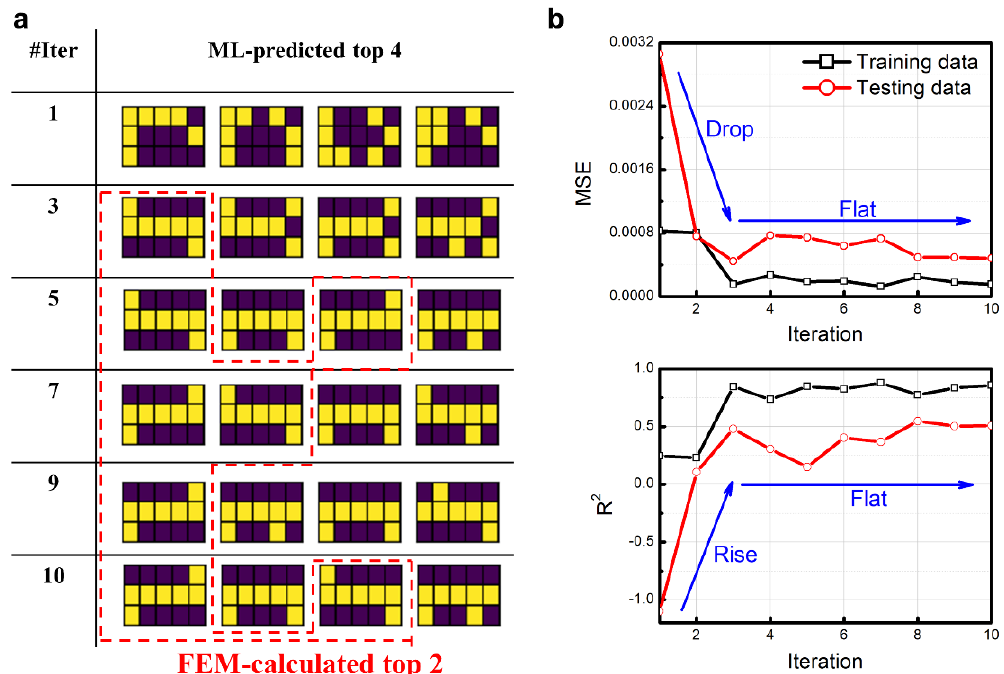
Figure 6. Iterated results and evaluations for the calculation domain discretized into 15 blocks by the CNN-based optimal strategy. ( a ) Top 4 ML-predicted sample configurations in each iteration. The sample configurations inside the red dashed-lined domain are the FEM-calculated top 2 configurations. ( b ) The relationship between evaluation functions MSE and R2 and iteration numbers. Black curves with open rectangles are for training dataset. Red curves with open circles are for testing dataset.